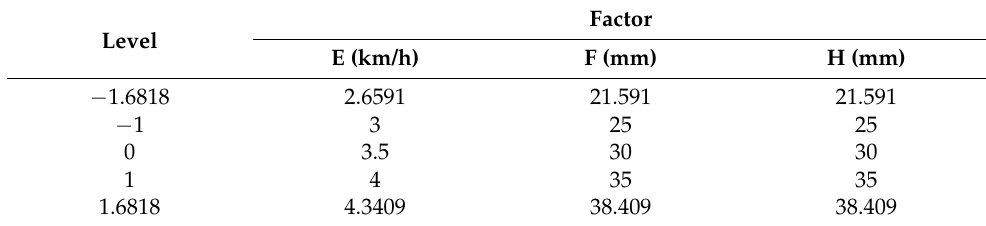
Table 8. Test scheme factors and levels of operation